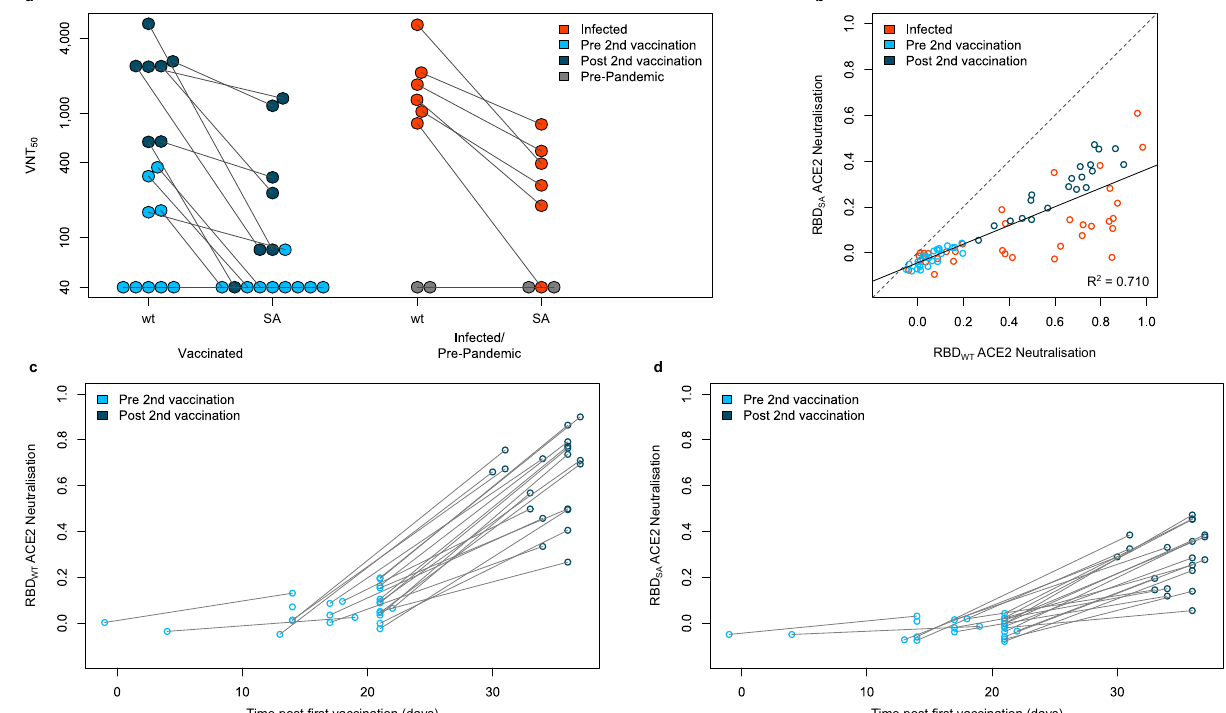
Fig. 4 South African RBD variant has decreased neutralization compared to wild-type in vaccinated and infected samples. Neutralization for the South African variant (SA) displayed as virus neutralizing titers (VNT 50 ) was measured in a virus neutralization assay compared to a wild-type variant (wt) ( a ) with sera from vaccinated (pre second vaccination (light blue, n = 9), post second vaccination (dark blue, n = 7)), infected (red, n = 6), and negative (pre- pandemic) (gray, n = 2) individuals. To con fi rm the reduction in neutralization seen, an ACE2 competition assay was developed and used to measure neutralization capacity for wild-type RBD (wt) and the South African RBD mutant (SA) ( b ) on sera from vaccinated (pre second vaccination (light blue, n = 25), post second vaccination (dark blue, n = 20)), infected (red, n = 35) and negative (pre-pandemic, gray, n = 20) individuals. 0 indicates that no neutralization is present while 1 indicates maximum neutralization. A linear regression ( y = − 0.044 + 0.408 x ) for all samples is shown in gray with the R 2 included. When examining vaccinated samples only, wild-type neutralization ( c ) is signi fi cantly increased following the second vaccine dose. For South African neutralization ( d ), while it is increased following the second dose, there is a signi fi cant reduction when compared to wild-type. Lines in ( a ), ( c ), and ( d ) indicate paired samples from the same donor. Source data are provided as a Source Data fi